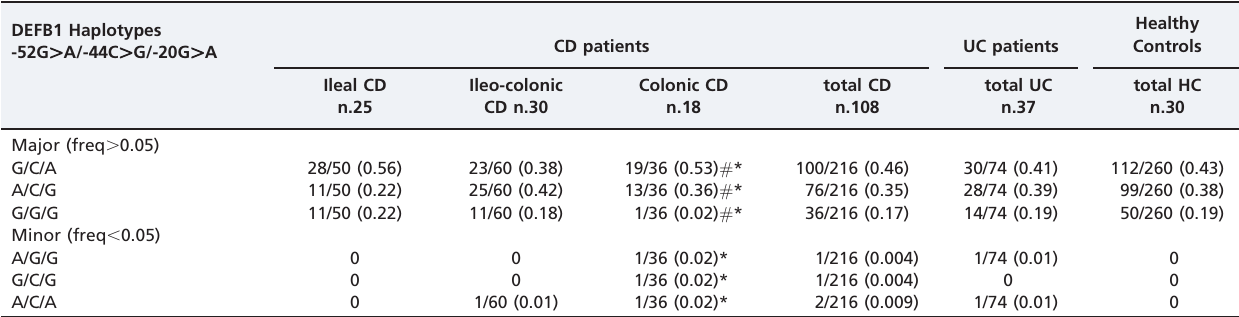
Table 2 - Haplotype counts (and frequencies) of 5’UTR DEFB1 polymorphisms in Crohn’s disease patients, ulcerative colitis patients and healthy controls. The Crohn’s disease patients are also stratified according to the anatomical localization of the disease. The p -values (uncorrected) , 0.05 are also indicated. DEFB1 Haplotypes -52G . A/-44C . G/-20G .